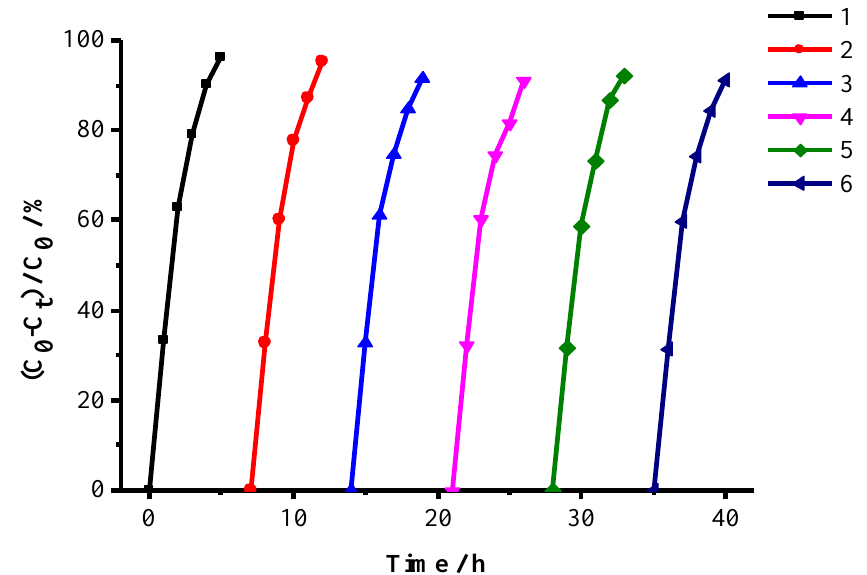
Figure 10. Cyclic tests for checking CuFe 2 O 4 /NG stability. The volume of the test solutions is 50 mL, which contained 100 mg/L ammonia-nitrogen at pH 9.5 under visible-near-infrared irradiation.